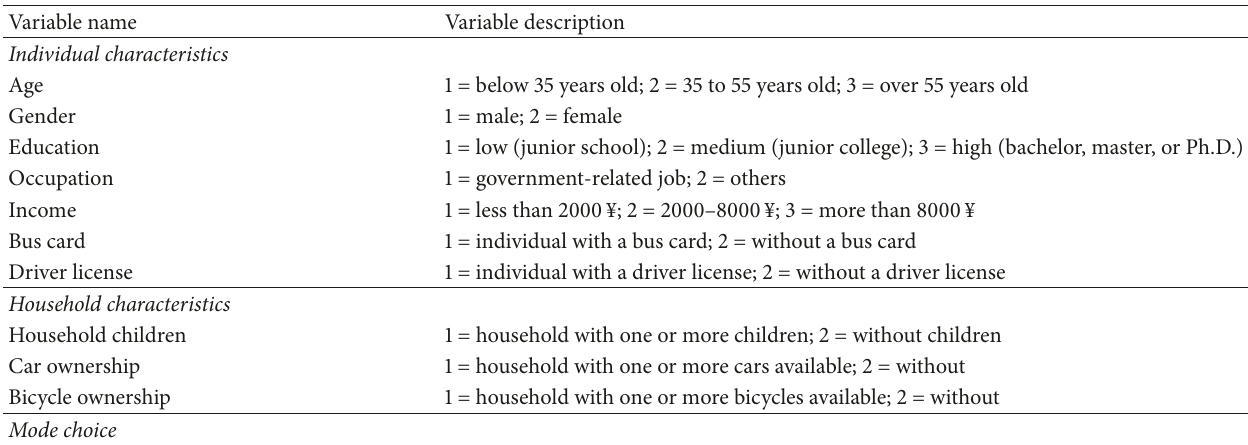
Table 1: Objective variables used in models and